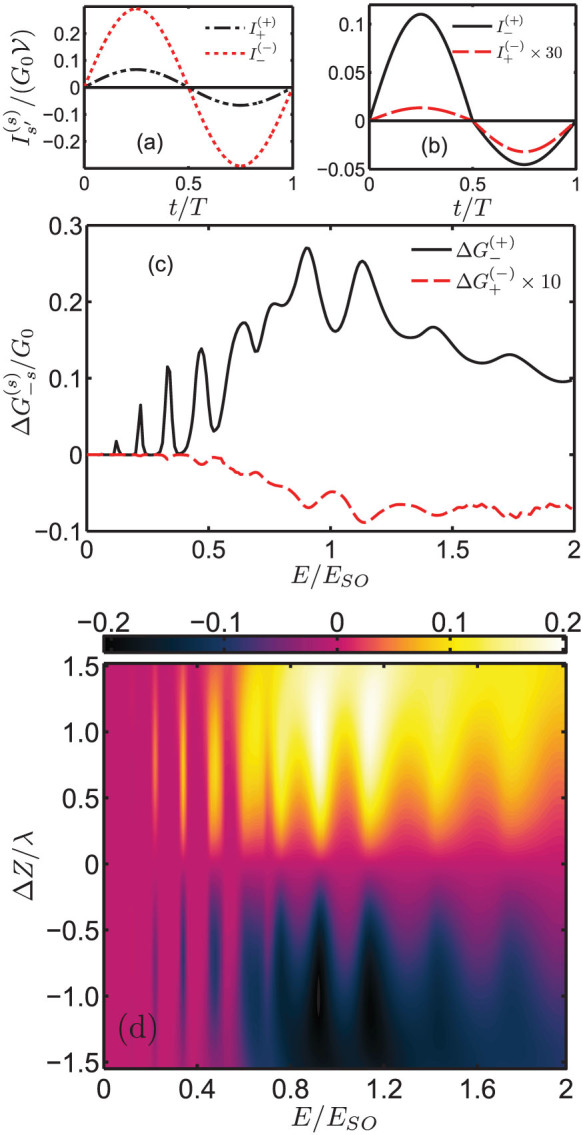
Tunneling conductance and ratchet conductance under an a.c. bias.(a) Time profile of  and; (b)  under small a.c. bias voltage. (c) Fermi level dependence of  (EF = 0.5ESO, d = 20 nm, V0 = ESO, ZL = 1.5 and ZR = 0.5). (d) ΔZ and Fermi level dependence of the ratchet conductance ΔGtot. When the asymmetry of the interface potential is swapped from ZL>ZR to ZL<ZR, the ratchet current reverses its direction as signified by ΔGtot<0. When the Fermi level is very large, the ratchet current is suppressed.